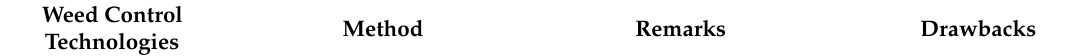
Table 1. Overview of precision weed control